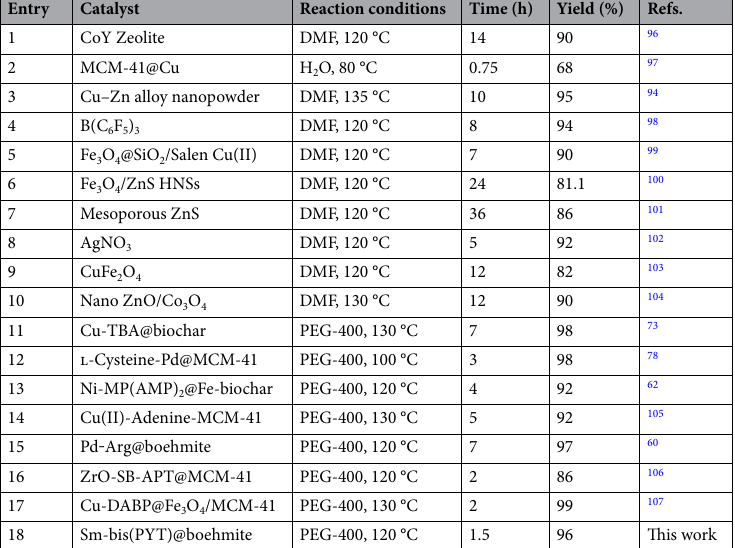
Entry Catalyst Reaction conditions Time (h) Yield (%)